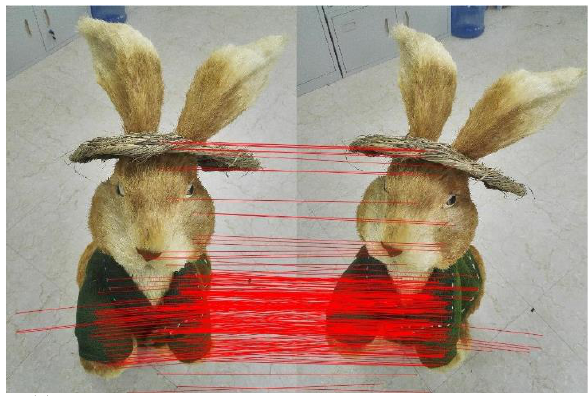
(c) Matching points after the proposed algorithm processing Figure 5. Corresponding point connection after preliminary feature matching (a) and screening algorithm processing, and the RANSAC algorithm (b) and the proposed algorithm (c) are used